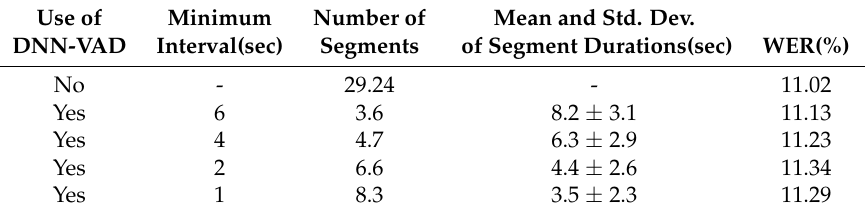
Figure 7. Performances of an ASR system using both the proposed fast parallel acoustic score computation method of BLSTM AM and the frame skip method, with the test set, in terms of ( a ) CPU and GPU usages (%), ( b ) number of hypothesis during Viterbi decoding, and ( c ) the number ( k ) of parallel decoded feature vectors of the proposed method for each acoustic score computation time. The green and blue lines indicate the CPU and GPU usages, and the straight and dotted lines indicate the proposed decoding without/with frame skip. Table 9. Average number and duration of split segments and syllable error rates (%) with and without DNN-voice-activity detector